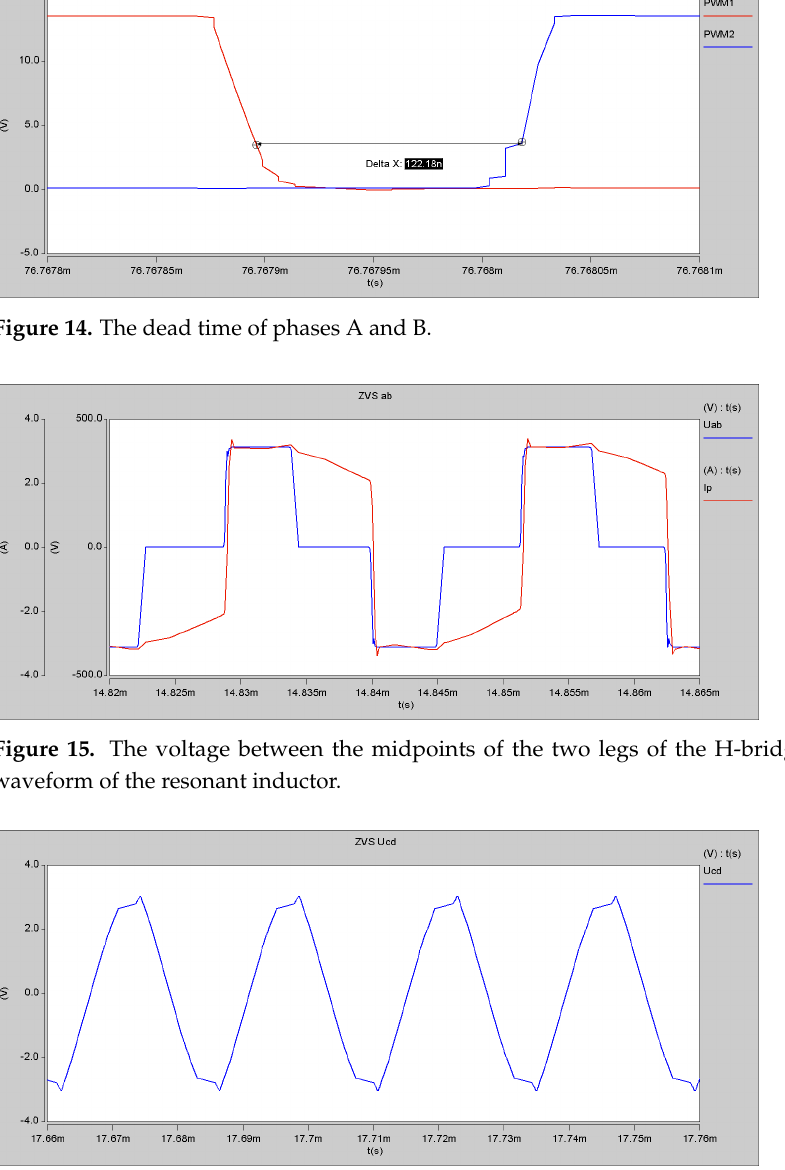
Figure 16. The voltage waveform of DC blocking